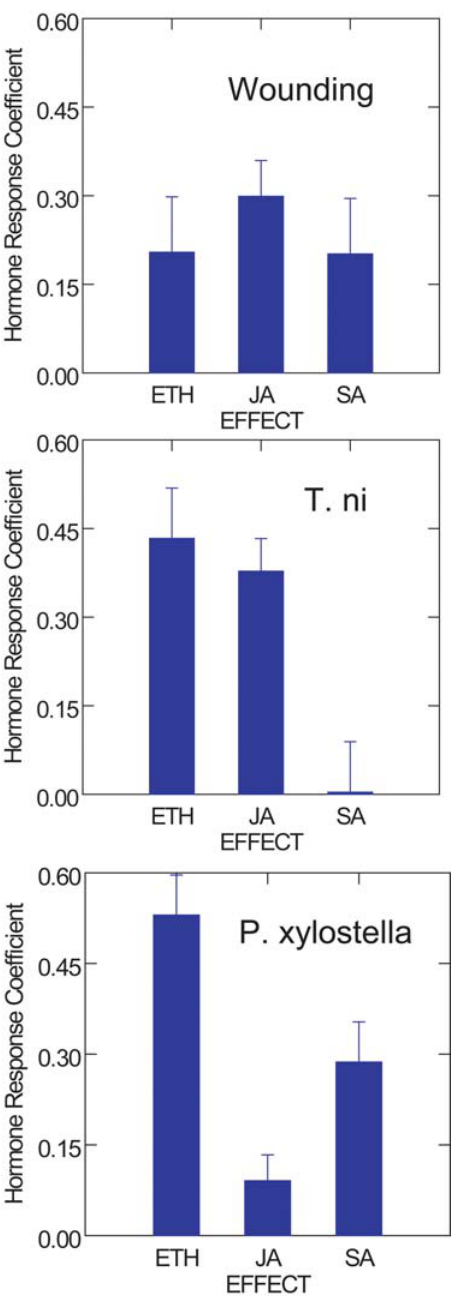
Figure 3. Hormone Response Coefficients for Wound-, T.ni-, and P. xylostella-Induced Changes. Hormonal control differs significantly between T. ni and P. xylostella (P , 0.01 by ANCOVA). Wound-induced changes in transcript levels are influenced by all three hormonal pathways, although JA has the strongest direct effects.